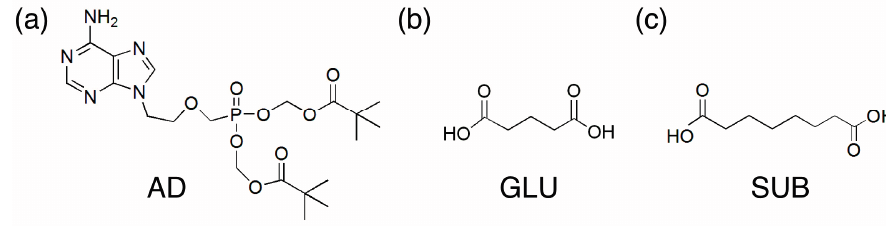
Figure 1. Chemical structures: ( a ) adefovir dipivoxil (AD); ( b ) glutaric acid (GLU); ( c ) suberic acid